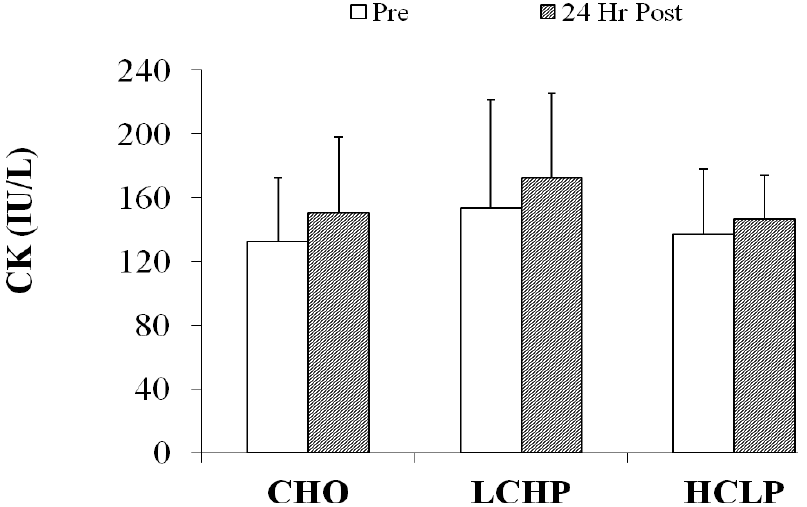
Figure 3. Influence of Exercise and Recovery Beverages on Serum CK Levels (Mean ± SD).